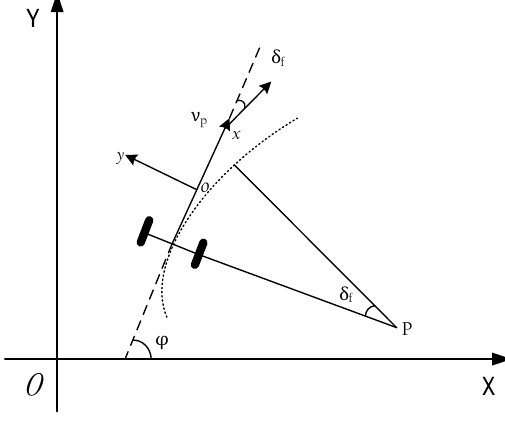
Figure 5. The vehicle kinematics model.